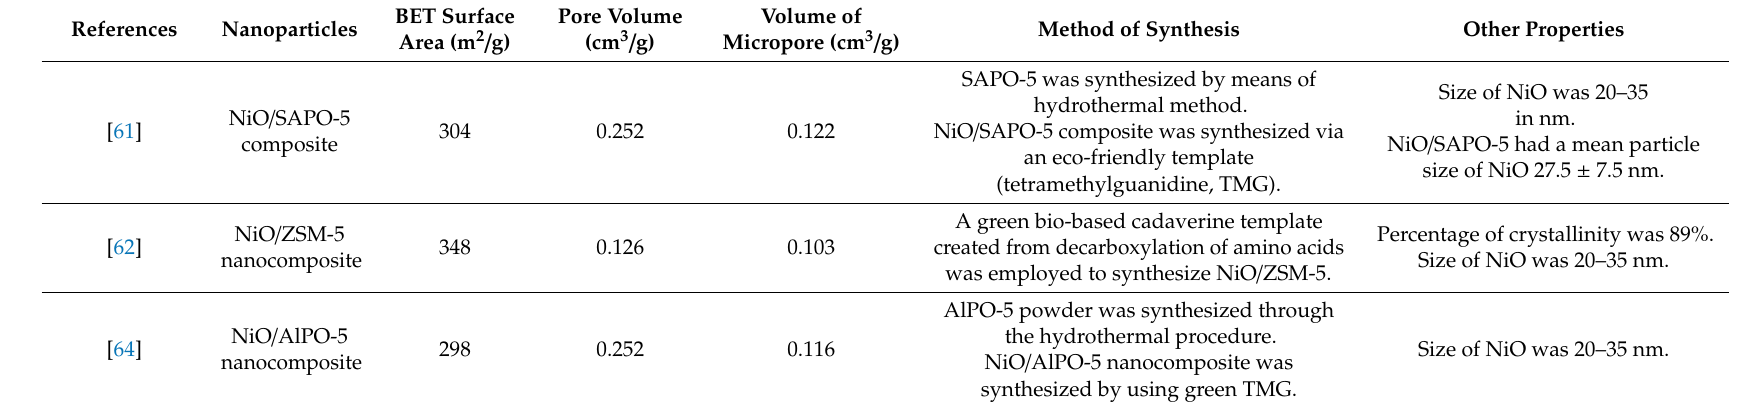
Table 1. Summary of nanocomposites properties used in this study.